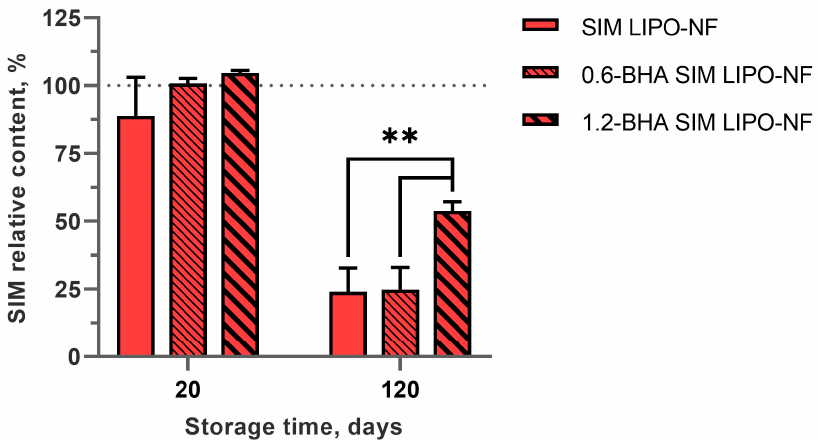
Figure 5. SIM relative content for the three nano fi brous formulations expressed as percentage of SIM relative to the initial drug content after 20 days and 4 months at accelerated storage conditions (40 °C; 70% RH). The data represent the average values ±SD ( n = 3). ** ( p < 0.01).